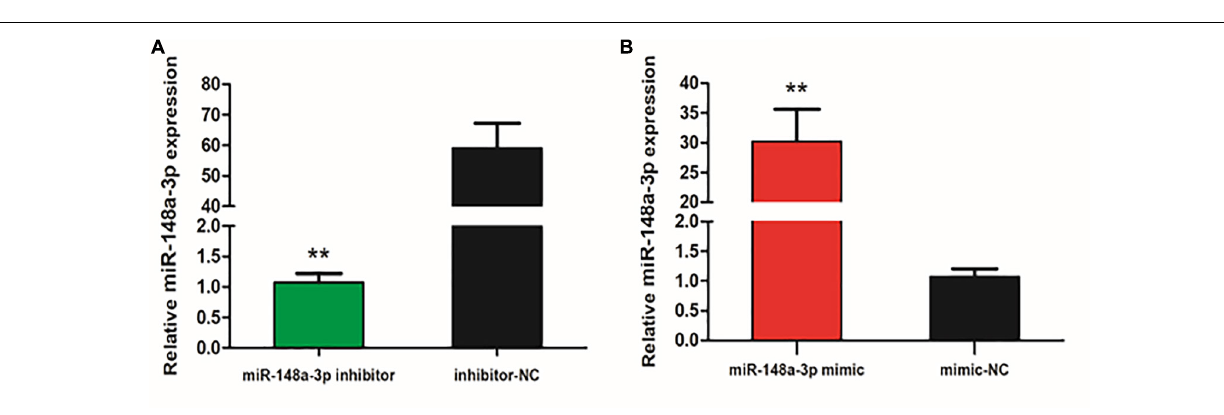
FIGURE 2 | Expression of miR-148-3p as modulated by a miR-148-3p mimic or inhibitor. (A,B) Expression of miR-148-3p in SMSCs was monitored using qRT-PCR following transfection with a miR-148-3p inhibitor or mimic. Data are presented as mean ± SEM of three individuals. The Student’s t -test was used to compare expression levels among different groups. ** P < 0.01 vs.